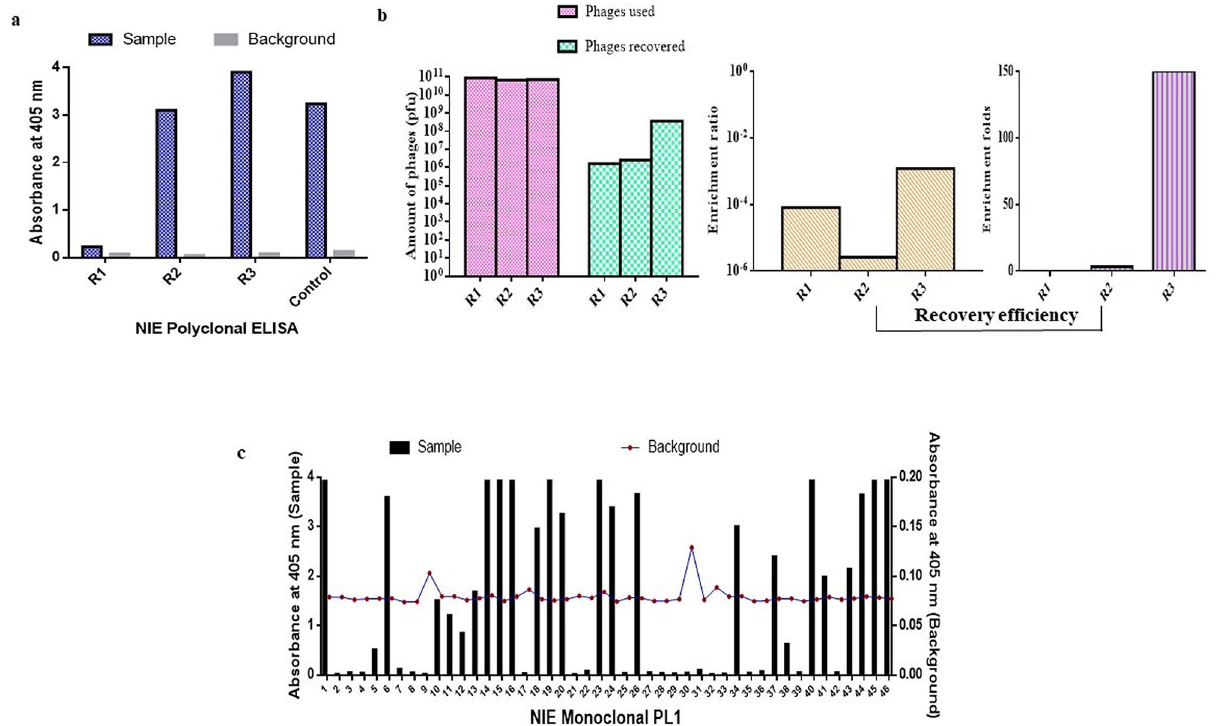
Figure 1. Isolation of rNIE specific monoclonal antibodies. ( a ) Polyclonal phage ELISA of rNIE antigen during the panning cycles. ( b ) Phage particles used and recovered in rounds 1 to 3 panning. ( c ) Representative of monoclonal phage ELISA analysis of scFv clones from helminth library against rNIE antigen. The positive control is a non-related protein that is reactive to the anti-M13-HRP antibodies and BSA was used as the negative control.